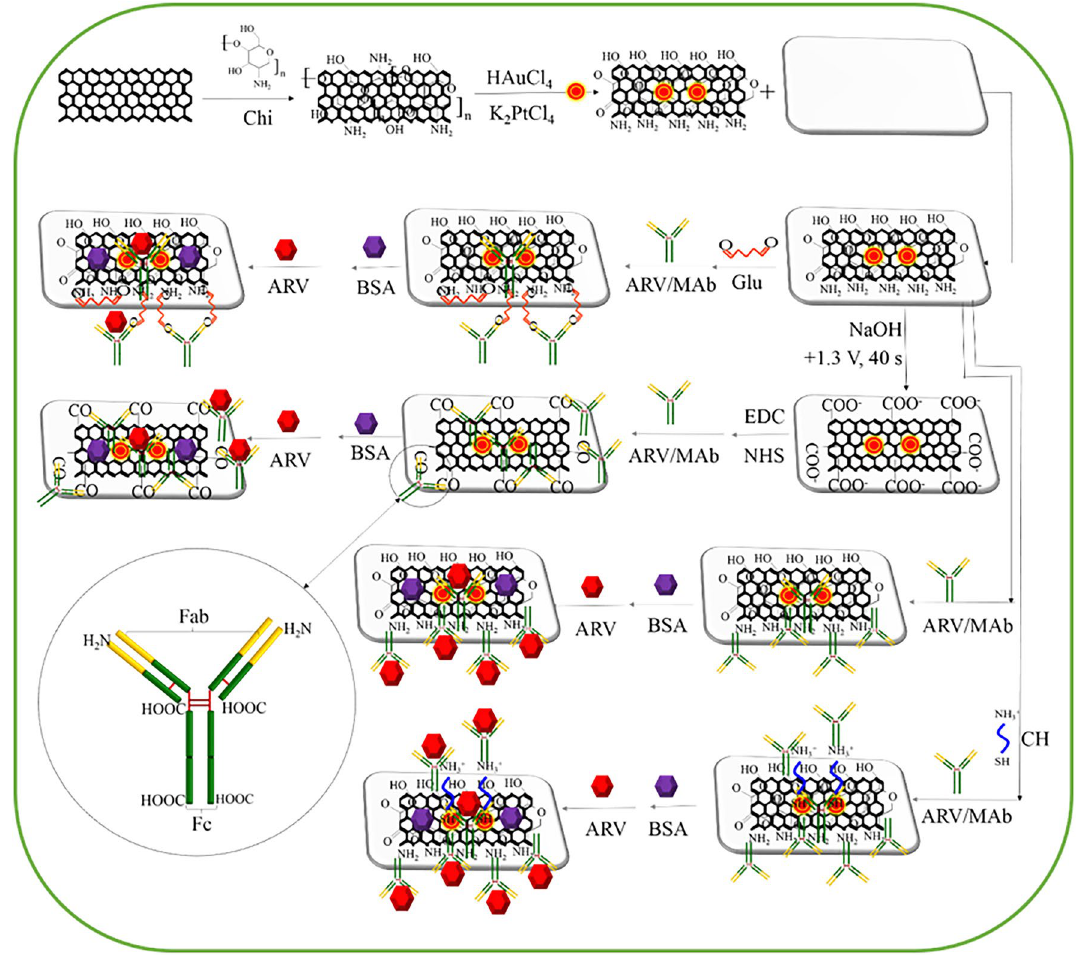
Figure 5. Schematic illustration of the electrochemical